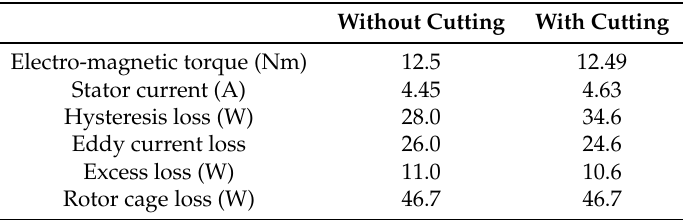
Table 4. Simulation